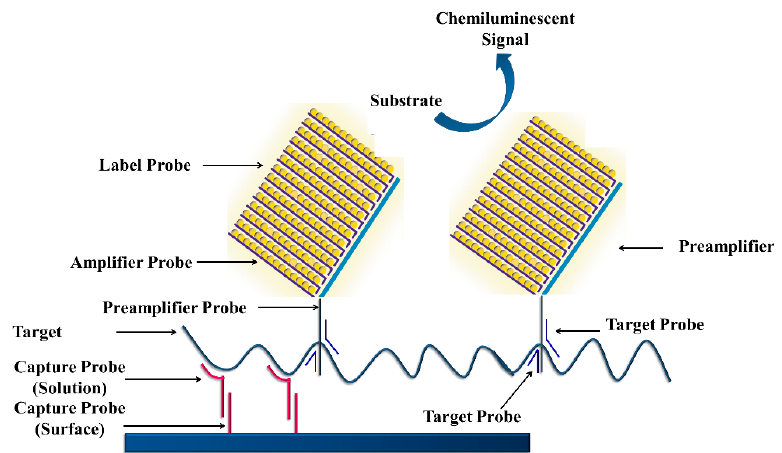
Figure 17. Schematic representation of signal amplification by branched DNA signal amplification technology (Reproduced with permission from [107]).